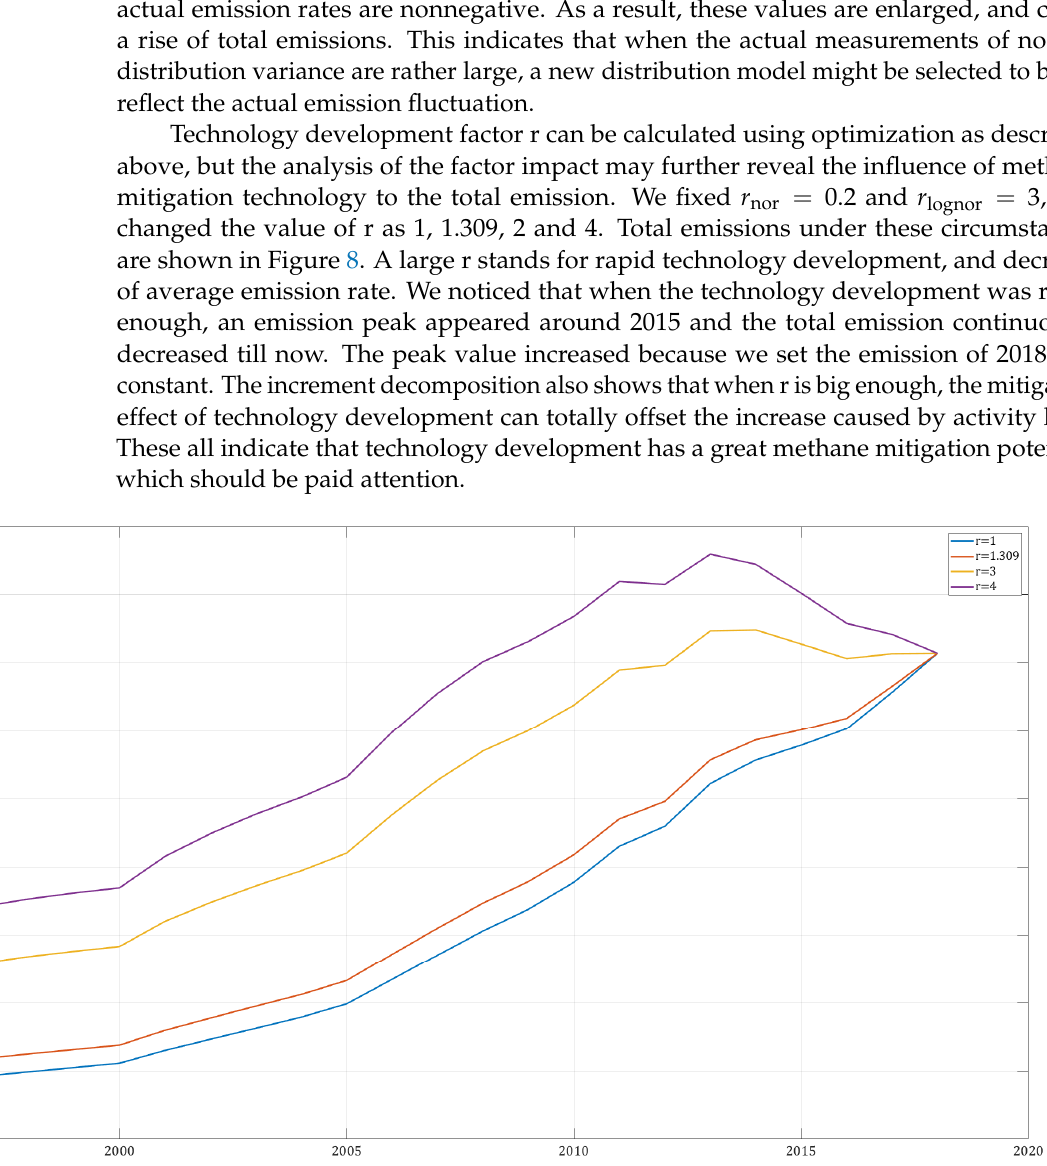
Table 4. Uncertainty of total emission under different combinations of r lognor and r nor in 2018. Unit of methane emission is kt.